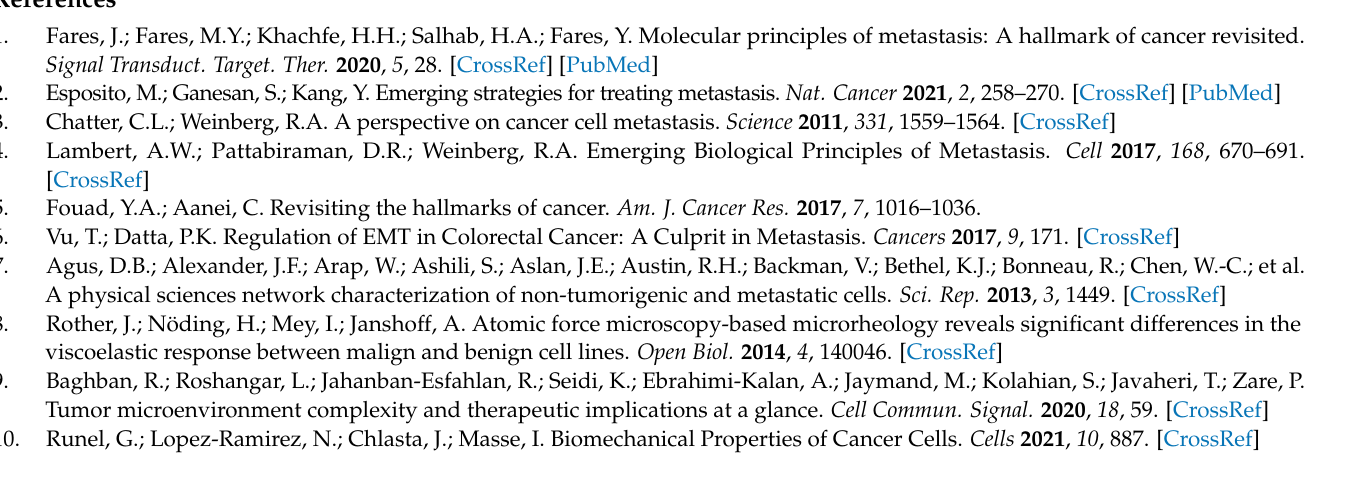
533 534 535 536 537 538 539 540